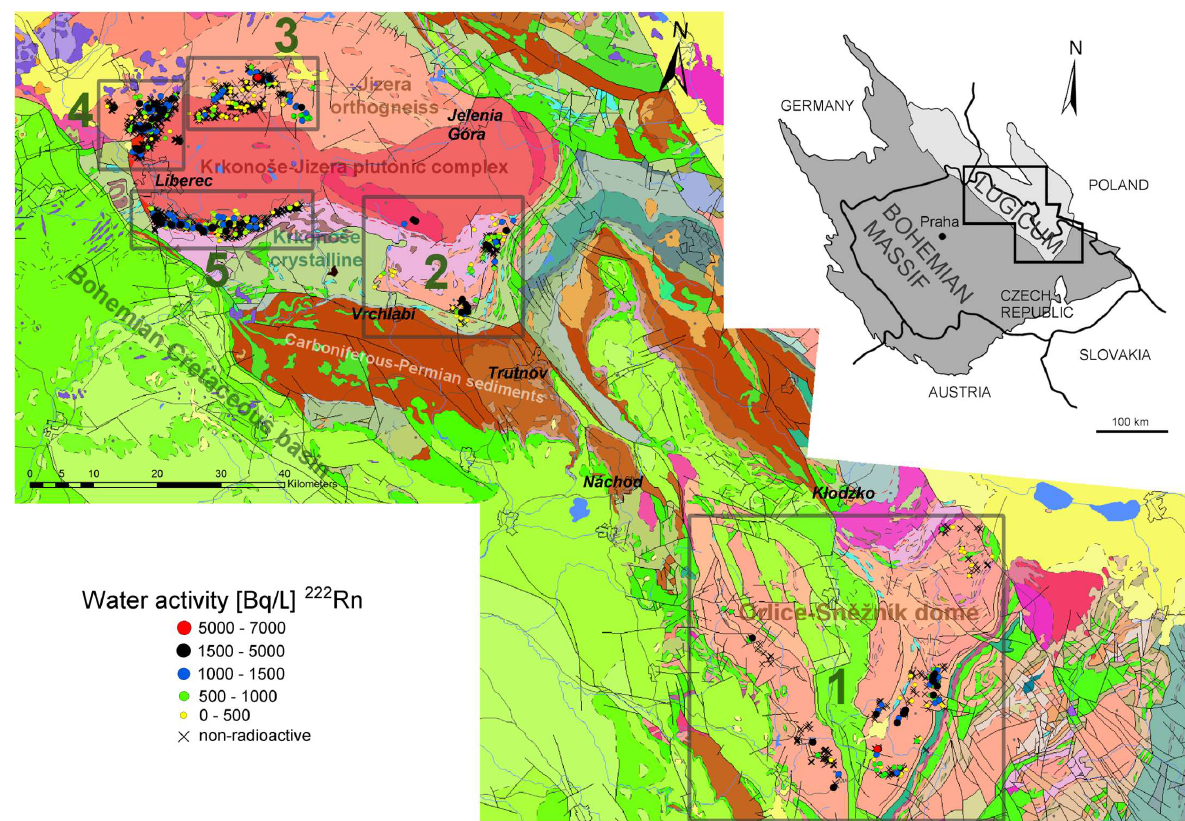
Figure 4. Lugicum: all data for the Rn-in-water activities measured in Claims #1–5. GIS composite based on a geological map of 1:500,000 (www.geology.cz) (accessed on 11 November 2021). A number of non-water-related gamma anomalies, which are called “dry gamma”, were also found in the area explored. The most interesting of these was found on the Ko- konín fault (Claim #5), where inhabitants recently built two houses directly on the outcrop of a vein with uranium mineralization [30].